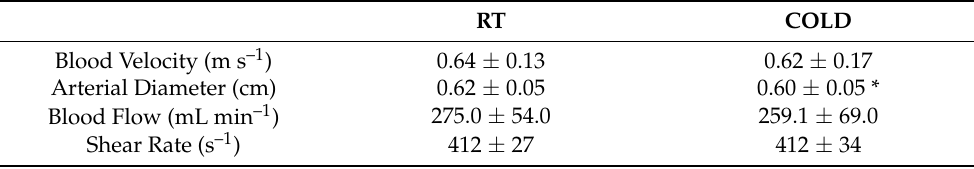
Table 2. Arterial hemodynamic